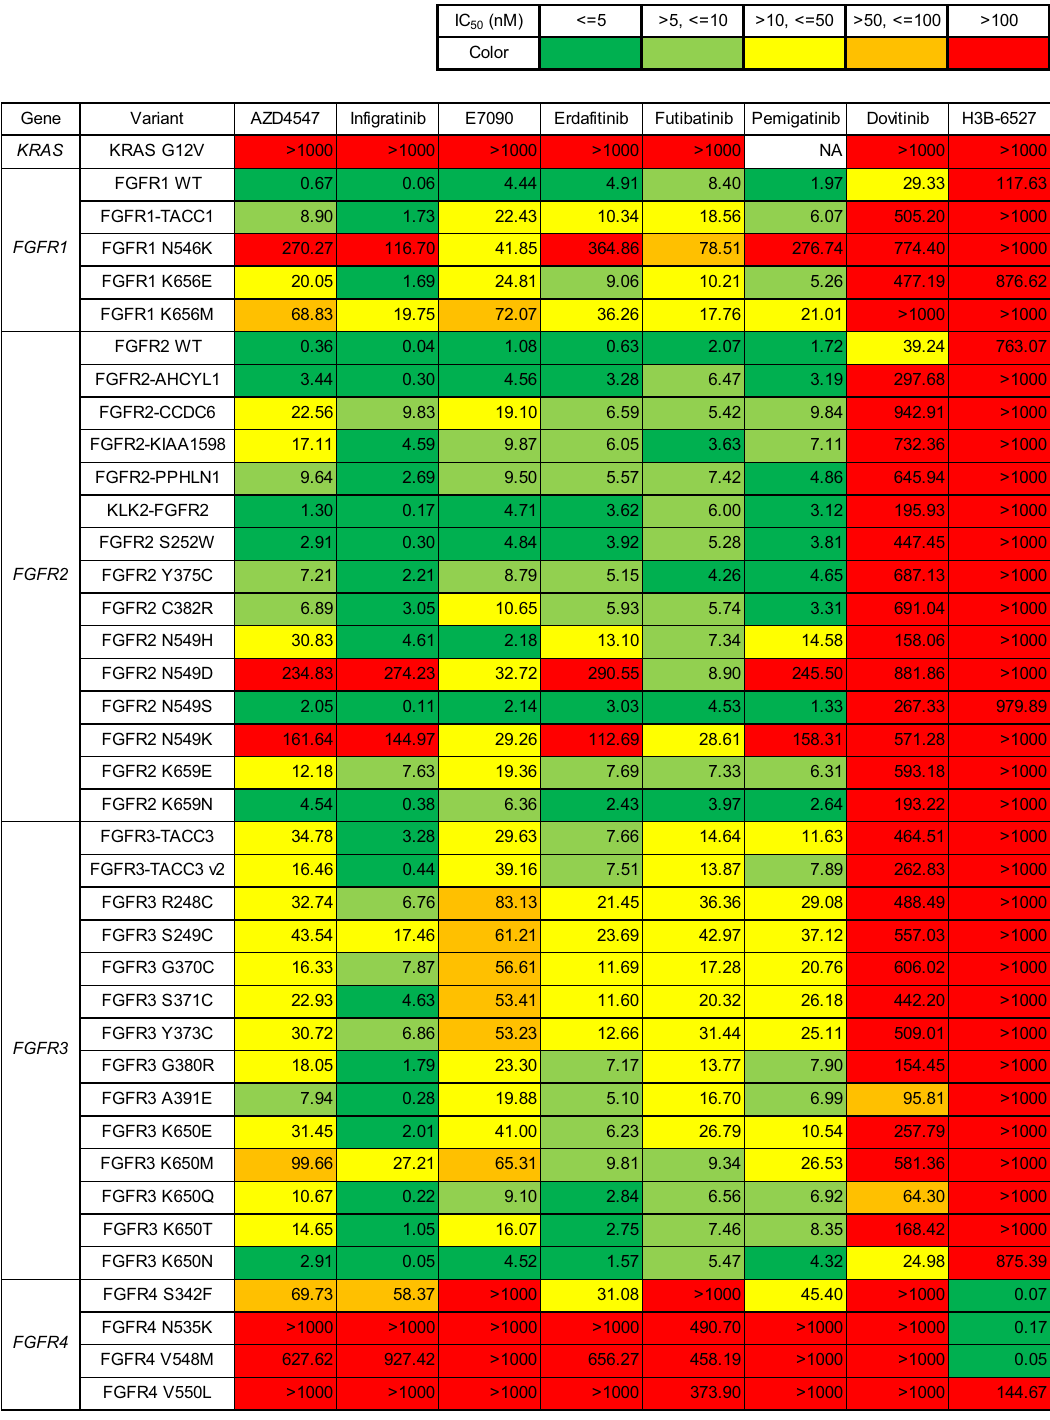
Fig. 4 The IC 50 values of FGFR-targeted drugs estimated using the MANO method. The IC 50 values of FGFR-targeted drugs against FGFR variants were evaluated using the drug sensitivity assay of the MANO method in 3T3